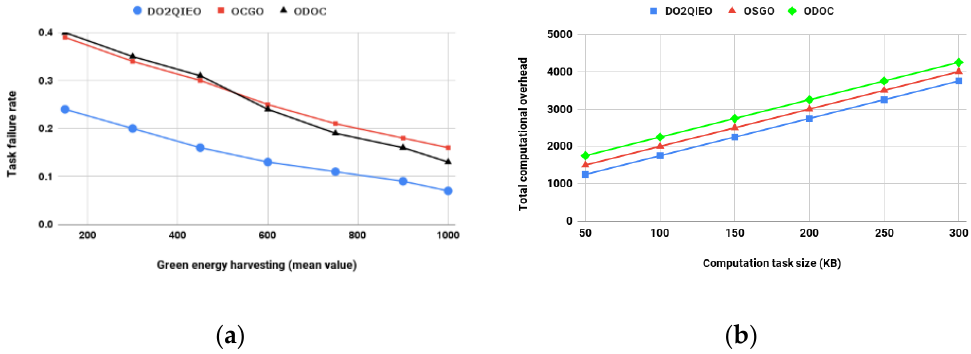
Figure 9. ( a ) Task failure rate performance with backup energy harvester module. ( b ) The impact of computing task size on total computational overhead in online mode (Figure ( a ) is on the left, Figure ( b ) is on the right).